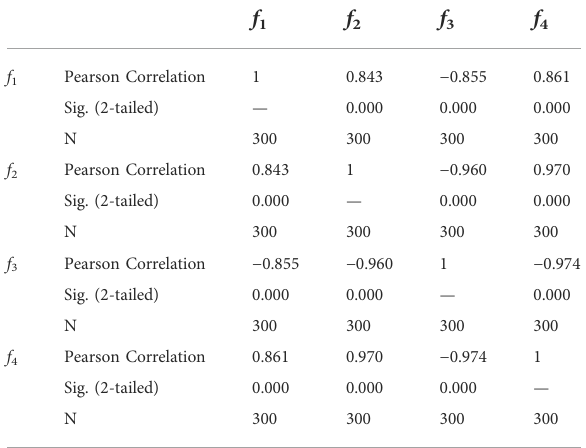
TABLE 6 Correlation analysis of the objective function in weight γ (cid:1) ( 0 . 25 , 0 . 25 , 0 . 25 , 0 . 25 )